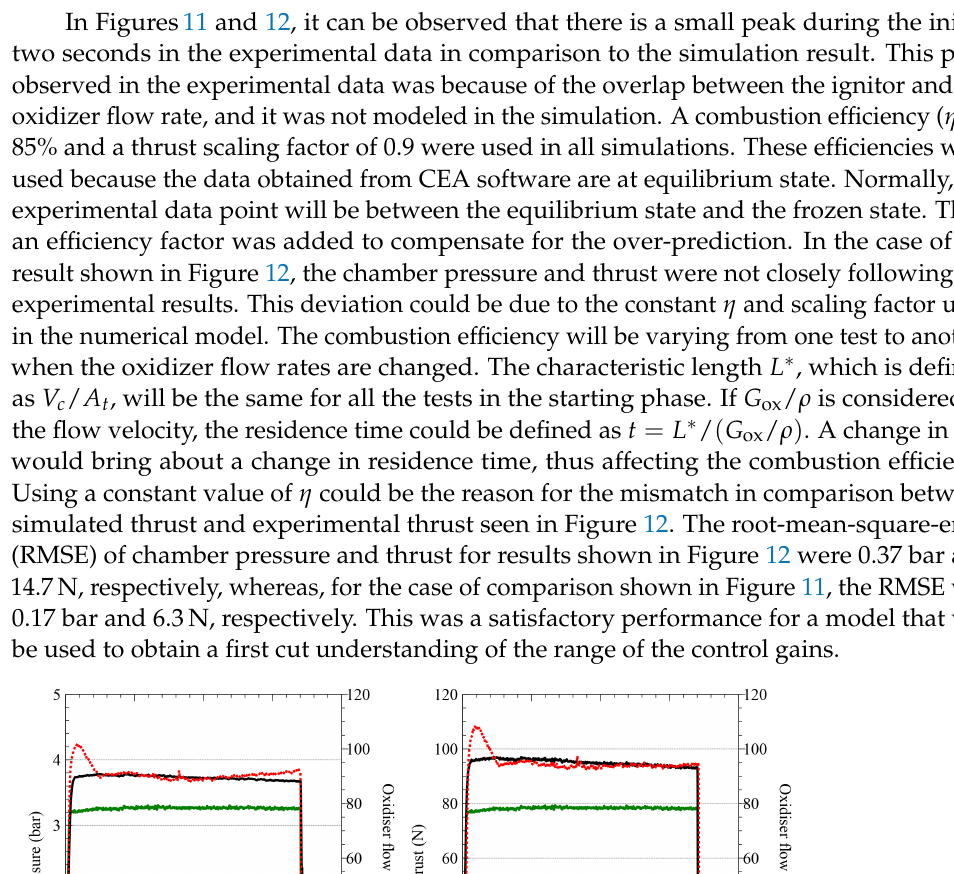
Figure 10. Throttling study. ( a ) pressure and thrust profile; ( b ) steps in throttling.